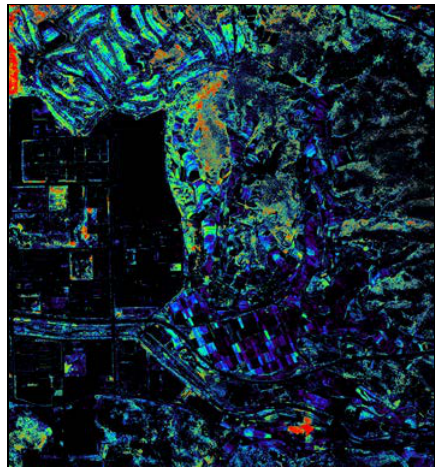
Figure 3. Vegetation index images: (a) NDVI (stretched between 0.1 and 0.9) of the aerial photo acquired in October 2, 2011, (b) NDVI (stretched between 0.1 and 0.9) of the aerial photo acquired in November 15, 2012 and (c) NDVI (stretched between 0.1 and 0.9) of the hyperspectral imagery cropped around the leakage point